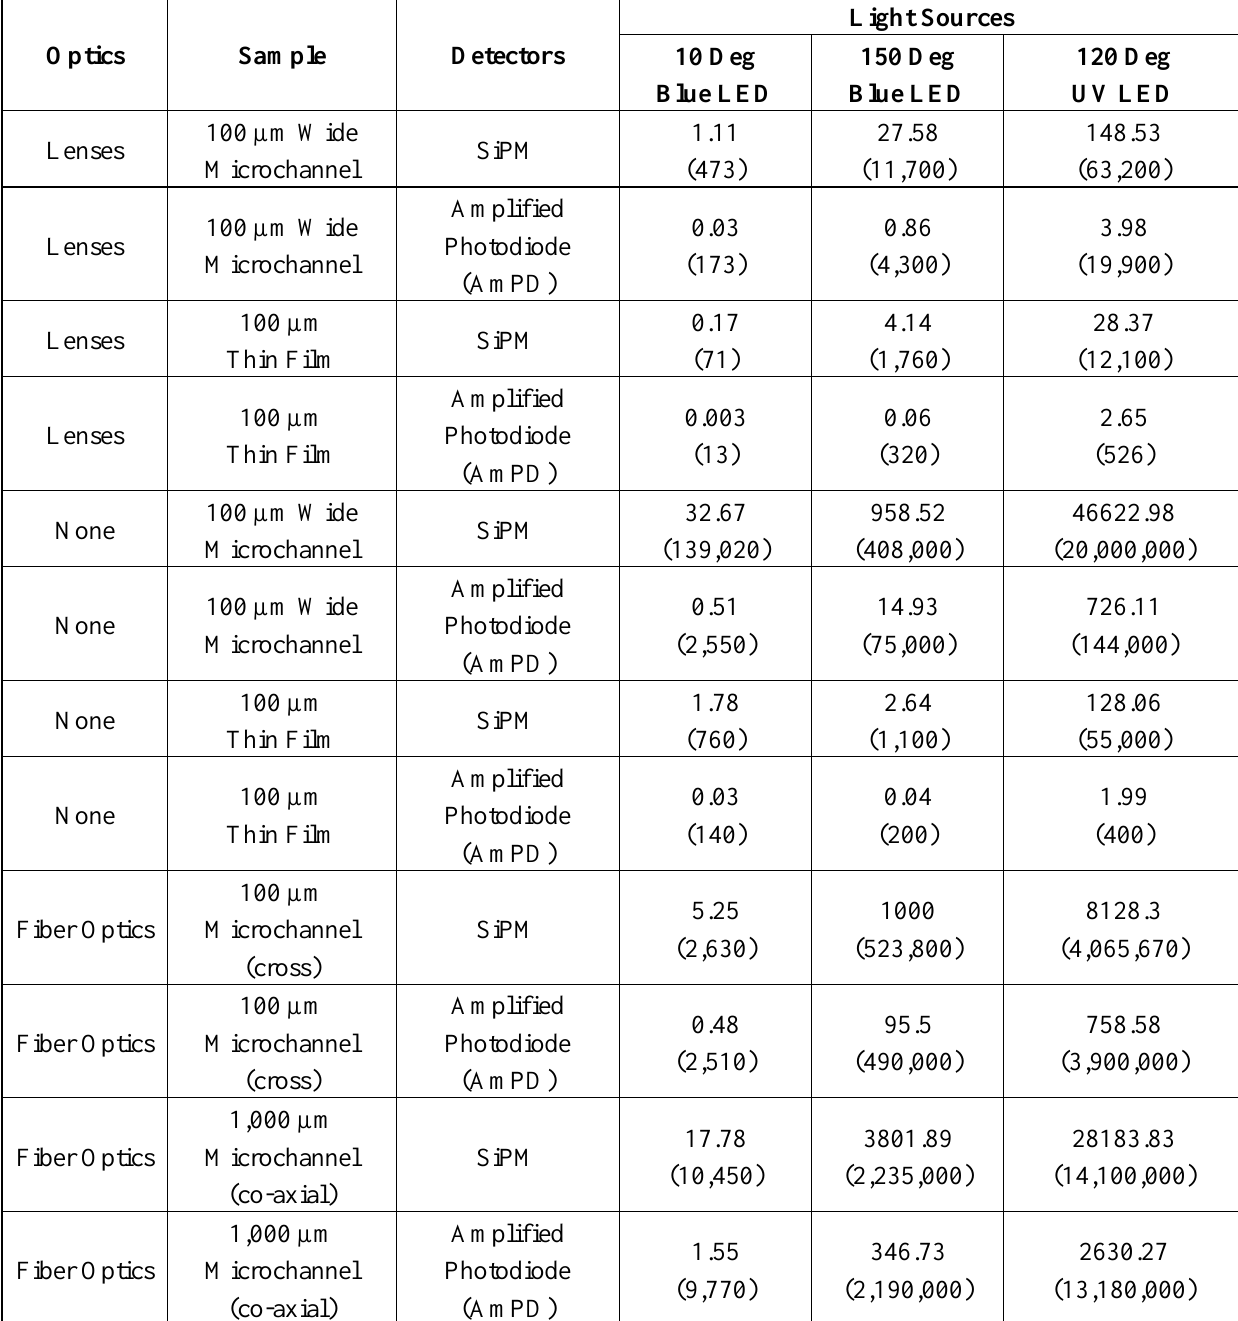
Table 1. The minimum detection limits (MDL) in nM and dynamic ranges (factors above the MDL in parentheses) for the calibration curves for the three sources, three optics options, three sample geometries, and two